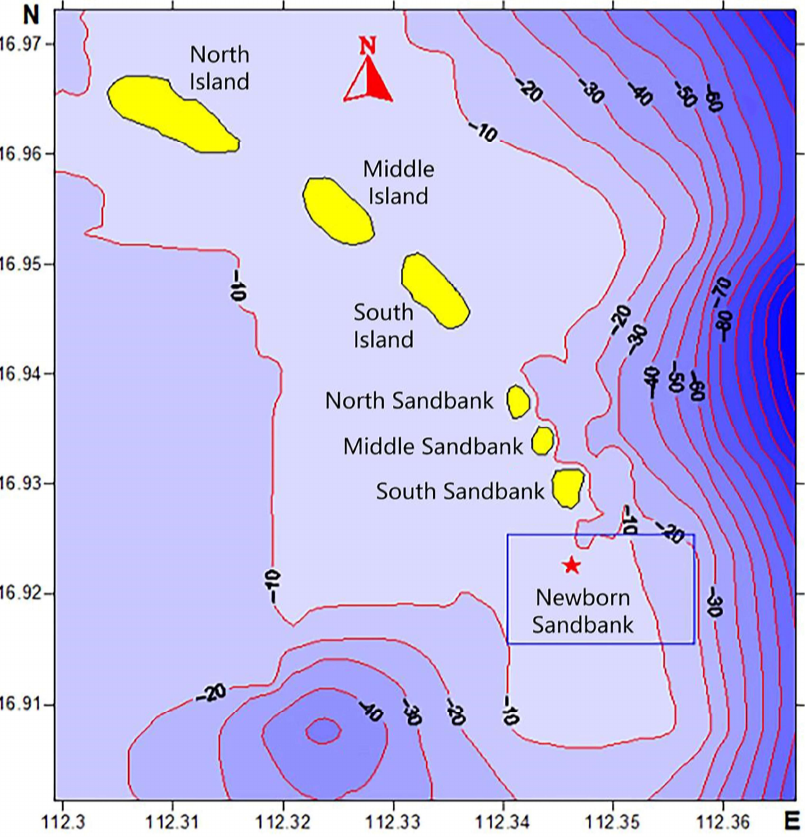
Figure 4. Underwater topographic features near the Qilianyu sea area and the newborn sandbank in the northern Xisha Islands.